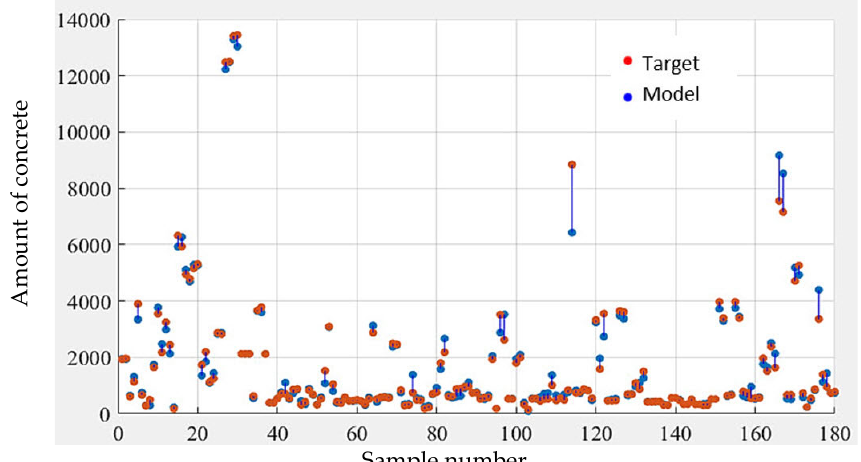
Figure 13. Comparison of the target values with the model values.